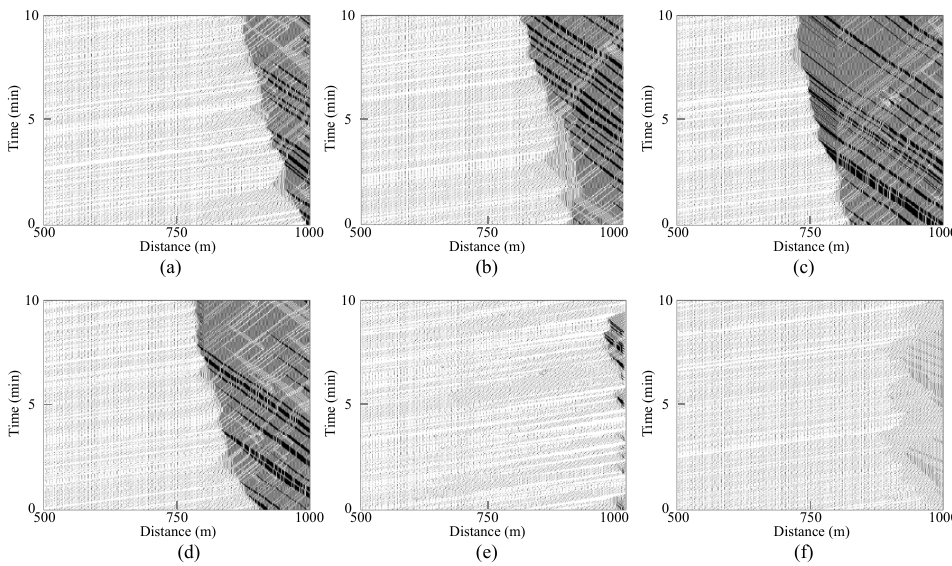
Figure 8. Temporal-spatial pattern of vehicle trajectories. ( a ) P CACC =0, ( b ) P CACC =20%, ( c ) P CACC =40%, ( d ) P CACC =60%, ( e ) P CACC =80%, and ( f ) P CACC =100%.